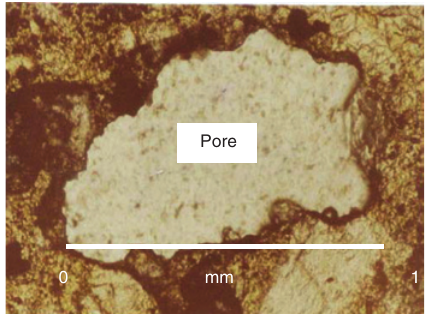
Figure 2 The pore structure of the Isparta-Karakaya pumice.